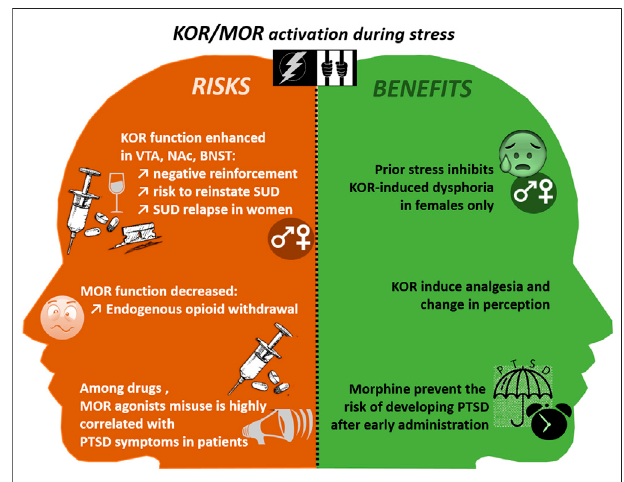
FIGURE 3 | The risks and bene fi ts of MOR and KOR activation during and after traumatic events. BNST, Bed Nucleus of the stria terminalis; KOR, Kappa Opioid Receptor; NAc, Nucleus Accumbens; PTSD, Post Traumatic Stress Disorder; SUD, Substance Use Disorder; VTA, Ventral Tegmental